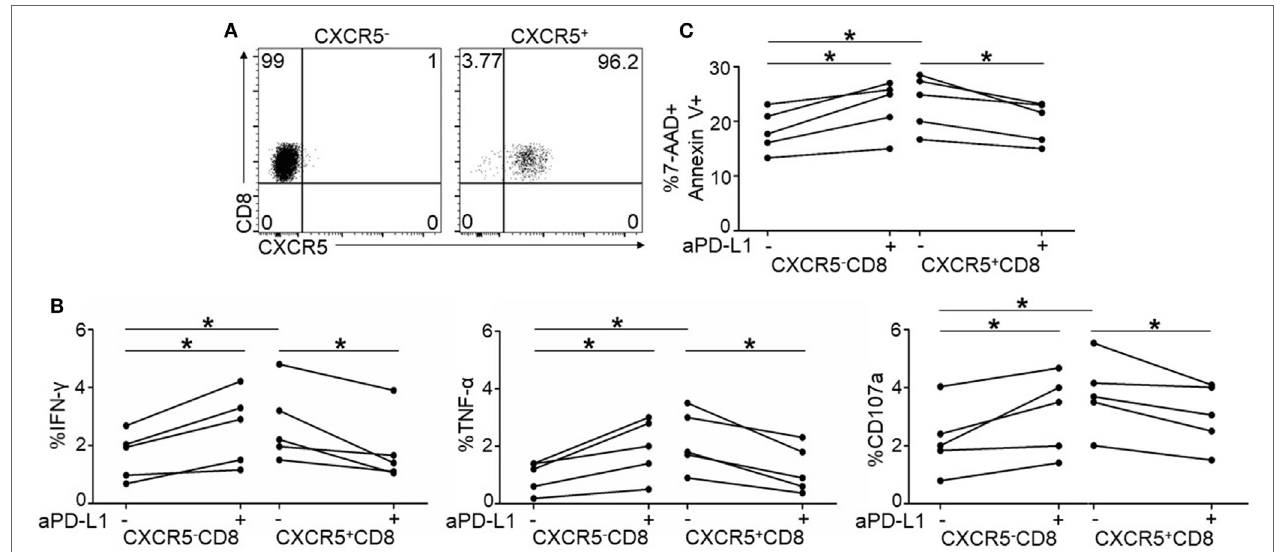
FigUre 5 | Purified CXCR5 + CD8 + T cells exhibit different response to programmed cell death 1 (PD-1) blockade from CXCR5 − CD8 + T cells. (a) Representative flow cytometric data of FACS sorted CXCR5 ‒ (left) and CXCR5 + CD8 + T cells (right). Data are representative of five individual samples. (B) Purified CXCR5 − and CXCR5 + CD8 + T cells from HIV-infected patients were stimulated for 8 h using HIV overlapping peptides with or without anti-PD-L1. Statistical analysis of intracellular IFN- γ (left), TNF- α (middle), and CD107a (right) staining on CXCR5 − and CXCR5 + CD8 + T cells (* p < 0.05). (c) Purified CXCR5 − or CXCR5 + CD8 + T cells from HIV-infected patients were co-cultured with Jurkat cells for 8 h with or without anti-PD-L1. Annexin V and 7-AAD staining was performed to show the killing functionality of the cytotoxic T cells (CTLs). Apoptotic Jurkat cells were compared between the different patient groups ( n = 5 for each